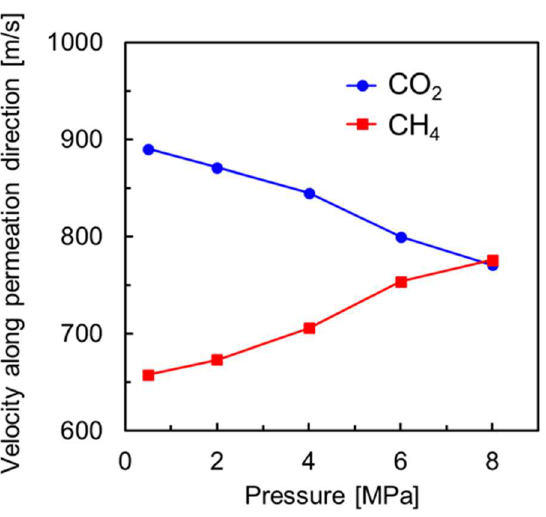
Figure 6. The velocity of gas molecules along permeation direction in a perfectly crystalline model of CHA zeolite membrane on NEMD simulation at different pressure conditions.